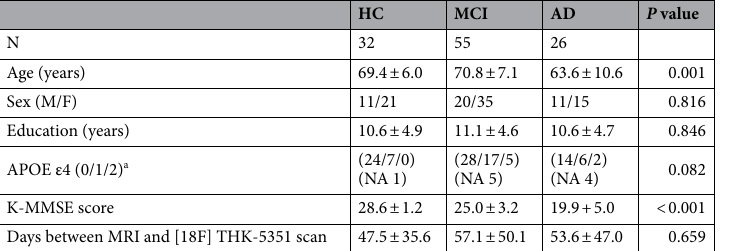
Table 1. Demographics of the study participants. HC, healthy controls; MCI, mild cognitive impairment; AD, Alzheimer disease; K-MMSE, Korean version of the Mini-Mental State Examination. a 0/1/2 indicates non- carriers/heterozygotes/homozygotes for APOE ε4